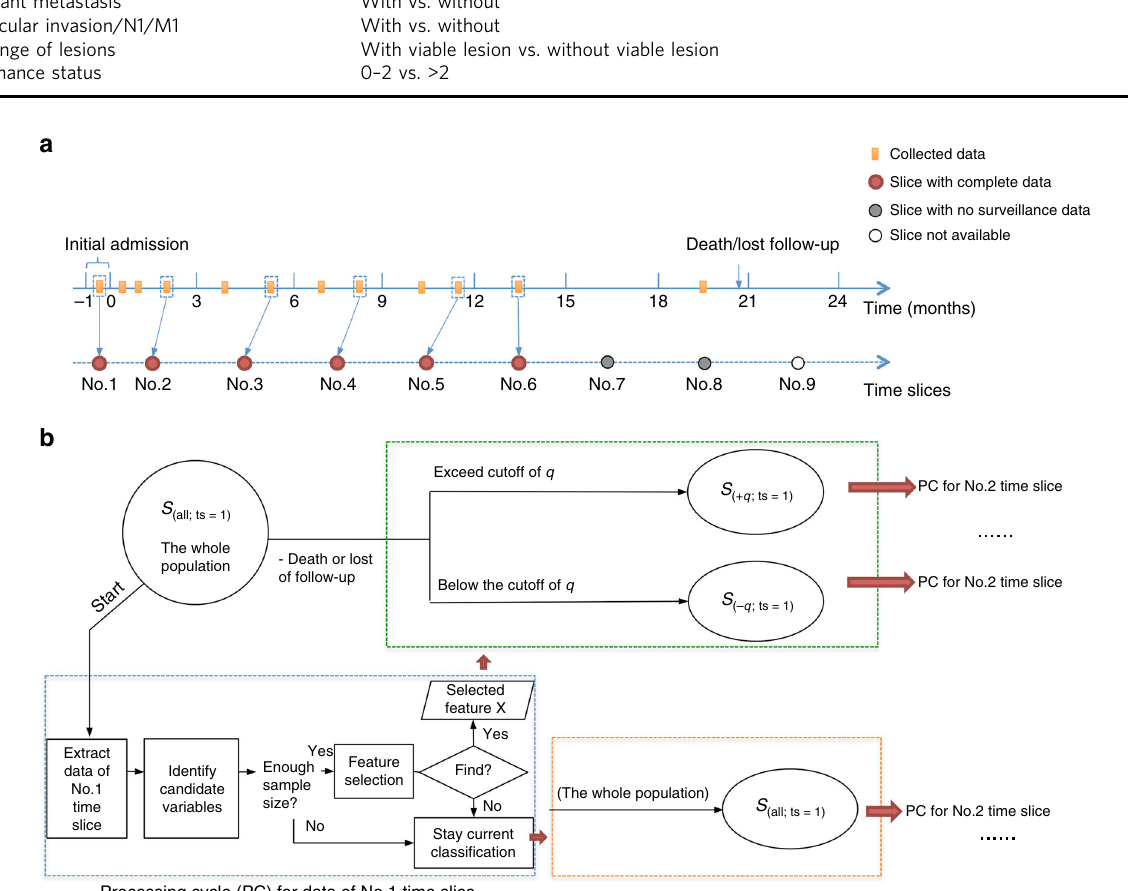
Fig. 4 Flowchart of study design. The time-series data of HCC patients were converted into data of time slices with constant time interval. Time slices in each case with complete data were enrolled for further analysis ( a ). Data in the fi rst time slice of the whole population would initially undergo the processing cycle (PC) for feature selection and subgroup subdivision. Then data of the next time slice in each subdivided subgroup sequentially undergo PC; the analytical cycles continue until the completion of the last time slice ( b